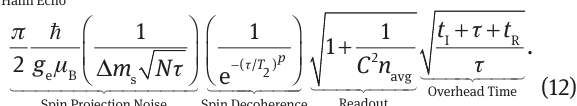
Properties of two notional diamonds used for performance simulations for a 1- μ m 3 QDM voxel. [N] is the concentration of nitrogen in the diamond. n is the number of nitrogen atoms per 1- μ m 3 voxel, NV/N = 10% of the N atoms are NV centers. A single NV axis is considered, N giving n with 10 5 fluorescence counts/s for each NV in a 1- μ m 3 QDM voxel. More NV centers per voxel increases the magnetic field NV,SA sensitivity because the rate of photons emitted scales with n T and T scaling of ∗ are from Ref. 2 2